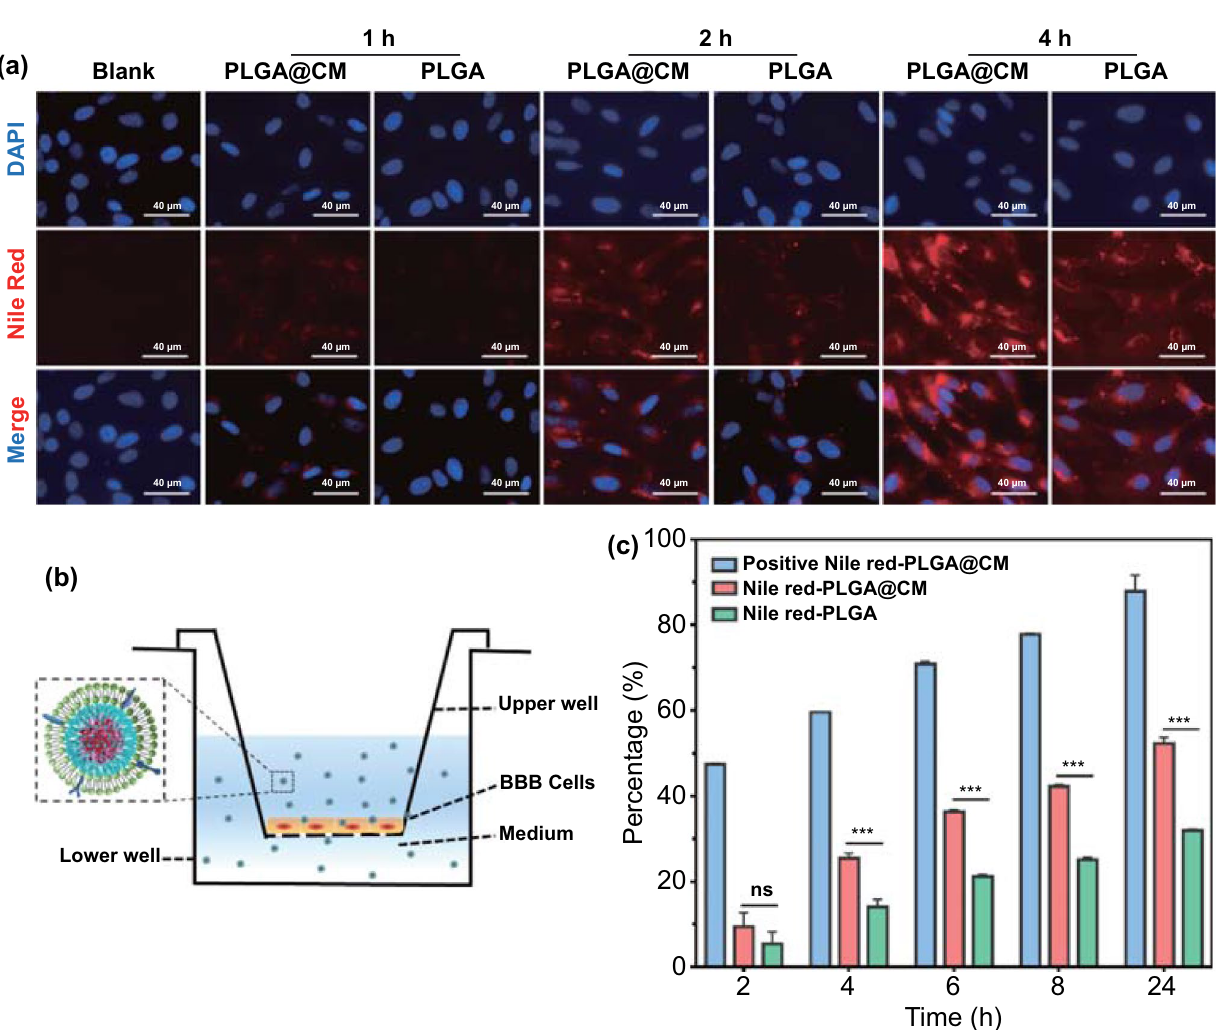
Fig. 3 Cellular uptake in hCMEC/D3 cells and in vitro BBB crossing efficiency of Nile red loaded PLGA@CM. a Confocal laser scanning microscopy images of hCMEC/D3 cells incubated with PLGA@CM and PLGA nanoparticles for different hours. b Schematic of in vitro BBB model. c Quantitative analysis of transcytosis efficiency of various nanoparticles through the BBB model in vitro. Data were expressed as mean ± s.d. ( n = 3). *** p < 0.001. n.s., not